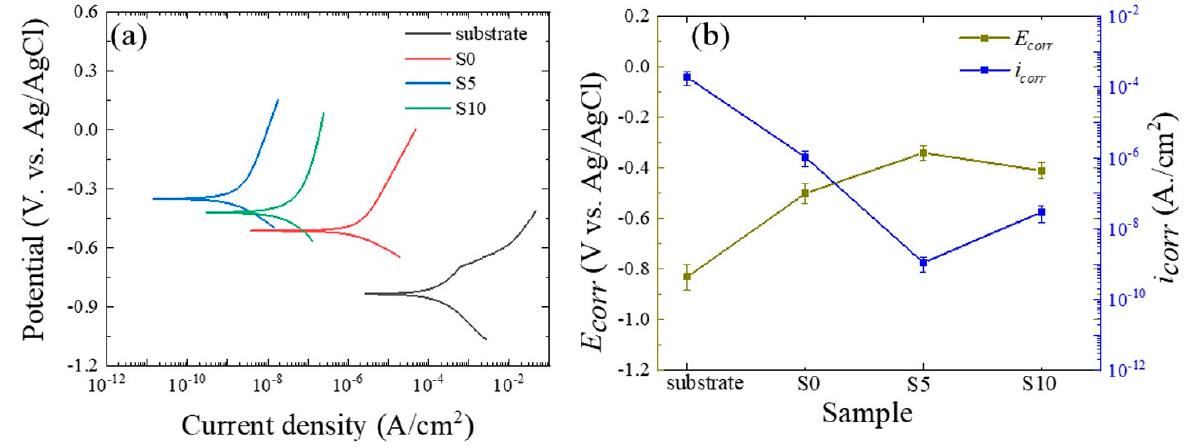
Figure 3. ( a ) PDP curves of the bare substrate and the S0, S5, and S10 samples in a 3.5 wt.% NaCl solution. ( b ) Change of E corr and i corr as a function of the SCi concentration.